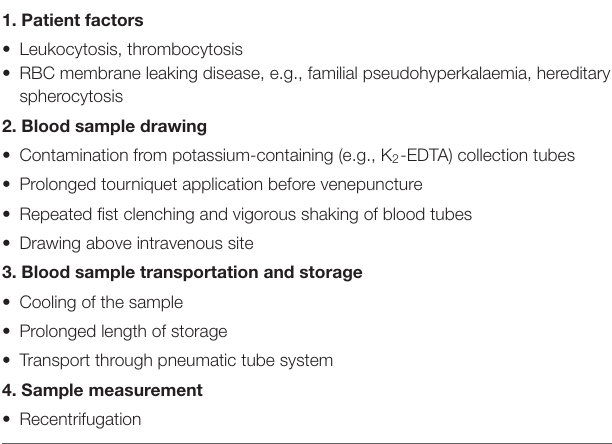
TABLE 1 | Common causes of